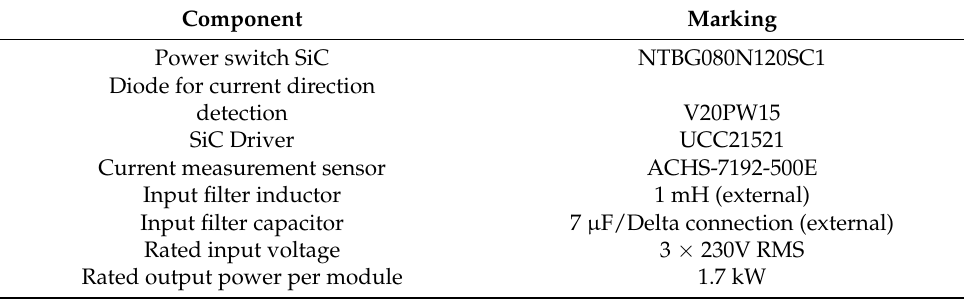
Table 2. Components used in the compact 3 × 1 matrix converter